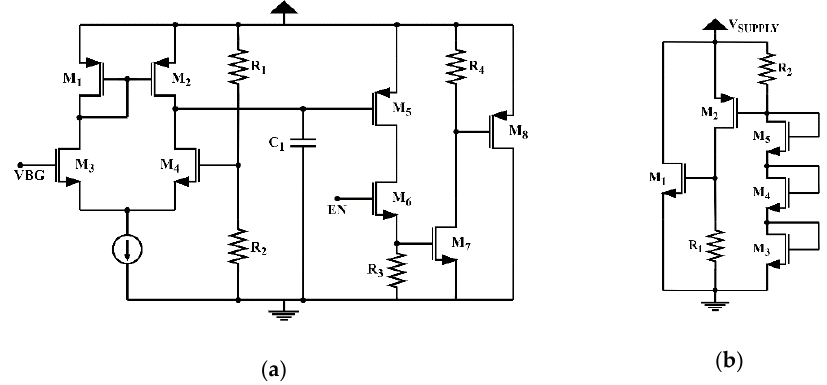
Figure 6. Schematics of the RFID tag’s voltage limiters: ( a ) high accuracy voltage limiter; ( b ) fast response voltage limiter.